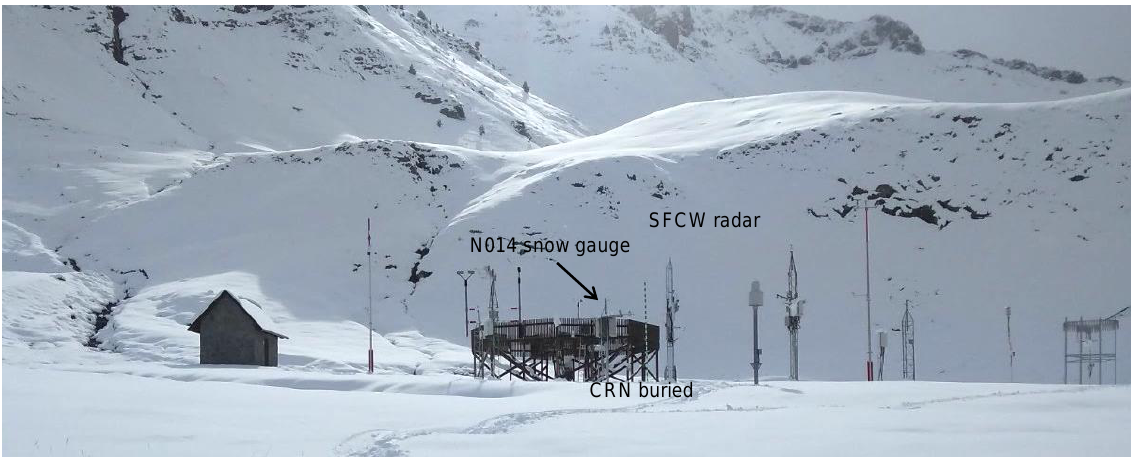
Figure 10. The AEMet Formigal–Sarrios test site located in the Spanish Pyrenees (42 ◦ 45 (cid:48) 40.6” N 0 ◦ 23 (cid:48) 31.8” W) at an elevation of 1800 m a.s.l. The cosmic ray neutron gauge (CRN) N014 from the Automatic Hydrologic Information System of the Ebro River Basin (SAIH-CHE) is buried by the snow. The SFCW radar is located near the